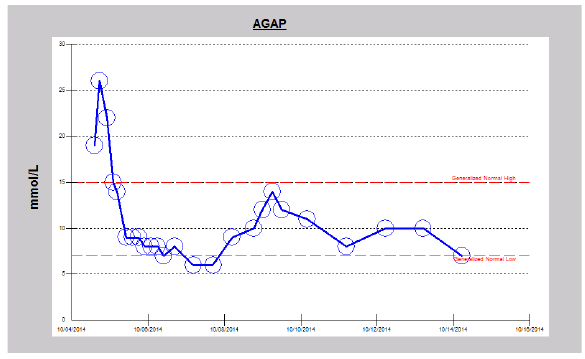
Figure 4. Trajectory of serum anion gap during the first 10 days of the admission with intentional ethylene glycol intoxication.